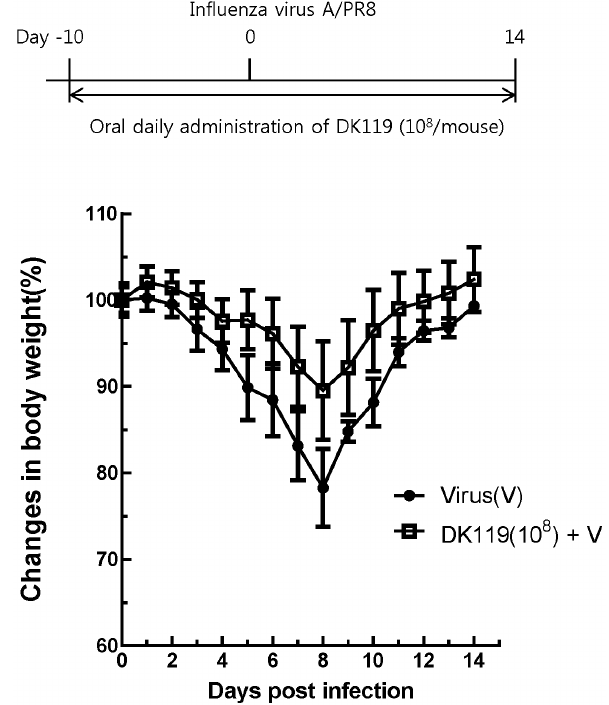
Figure 6. Oral administration of mice with a low dose of DK119 has protective effects against influenza virus (H1N1) infection. Mice (n=6) were orally administered DK119 (10 8 CFU/mouse daily) for 10 days before infection and for 14 days after infection with A/PR8 virus (1 LD 50 ). Body weight changes were recorded. Virus(V): A/PR8 virus infection, DK119 (10 8 ) + V: Oral administration with DK119 and virus infection.